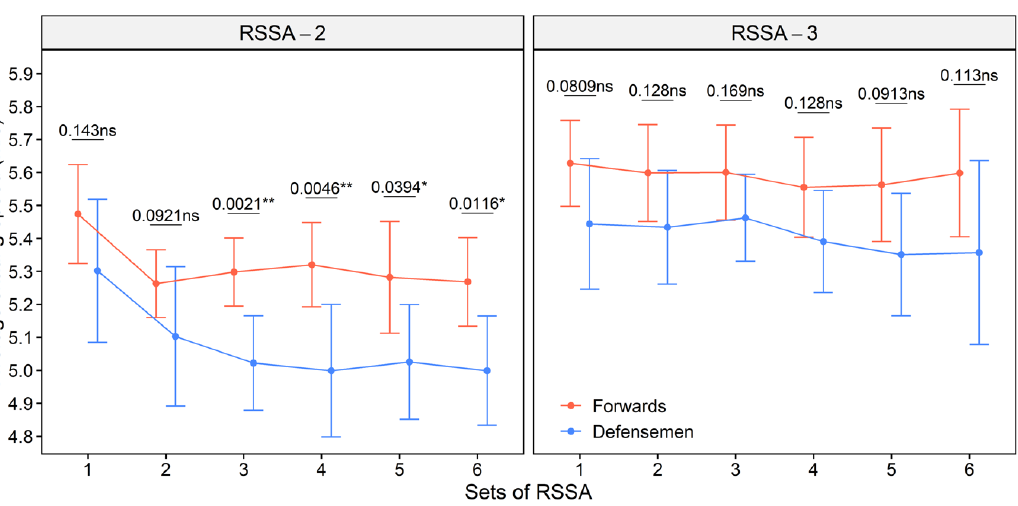
Figure 2. Average skating speed of the forwards and defensemen in RSSA-2 and RSSA-3 tests (ns—non-significant, * p < 0.05; ** p < 0.01). 3.3. Speed Decrement Figure 3 shows S dec of the forwards and the defensemen in RSSA-2 and RSSA-3 tests. The S dec is higher in RSSA-2 than RSSA-3, for any given set (except set 1), in both forwards and defensemen (the lower panel, Figure 3). The difference, however, is non-significant in all the cases. Defensemen showed higher S dec than forwards in all the sets, although the difference was significant only in the Set 1 of RSSA-3 (the upper panel, Figure 3).